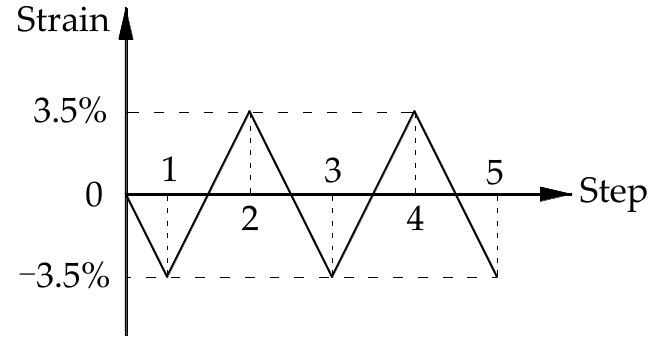
Figure 9. Cyclic loading protocol.